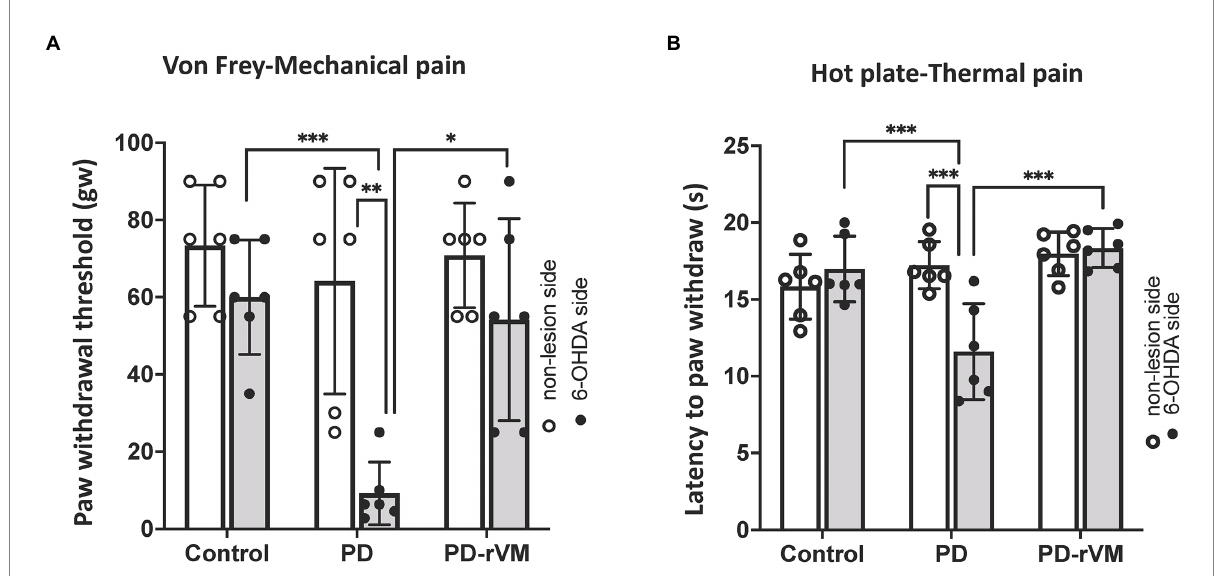
FIGURE 5 Mechanical and thermal pain tests. (A) In the von Frey filament test, the average paw withdrawal thresholds were significantly lower on the 6-OHDA lesioned side than the unlesioned side in the PD rats, whereas the PD-rVM group exhibited higher paw withdrawal thresholds to mechanical pain ( * p < 0.05, ** p < 0.01, *** p < 0.005). (B) In the hot plate test, the 6-OHDA-lesioned side of the PD-rVM group showed significantly longer latencies to paw withdraw compared to that of the PD group ( *** p <